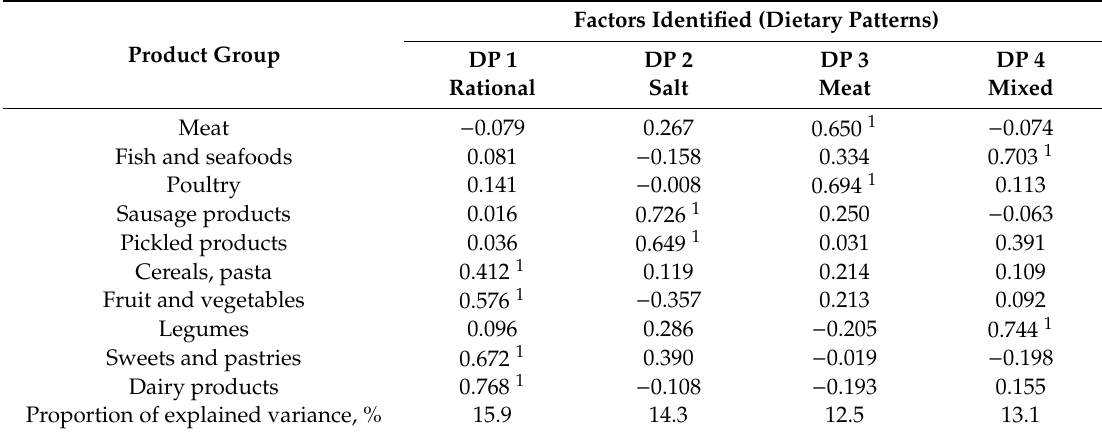
Table A9. Factor loadings of the principal dietary patterns identified (Volgograd region).